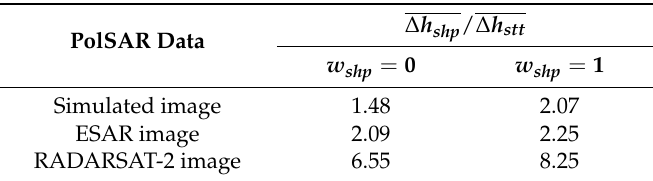
Table 4. Ratios ( ∆ h shp / ∆ h stt ) calculated for the simulated data, ESAR, and RADARSAT-2 image in segmentation with the shape weight of 0 and